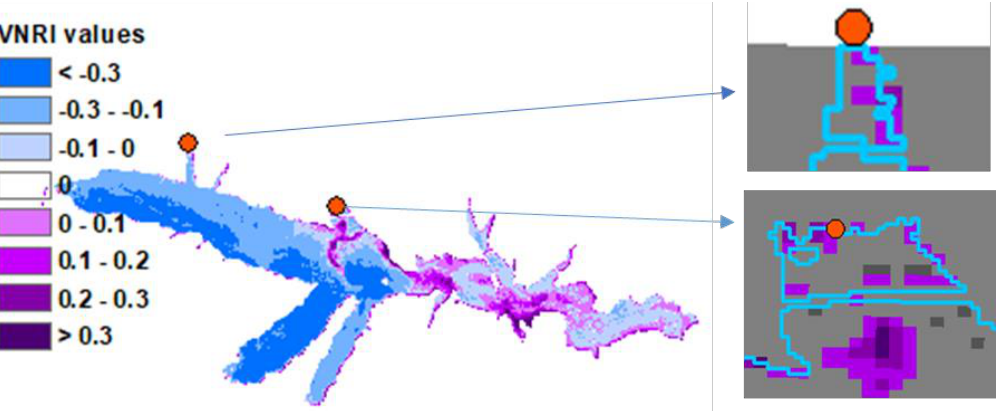
Figure 9. VNRI map of 27 February 2017. Orange circles correspond to the sites where ground samples were collected.